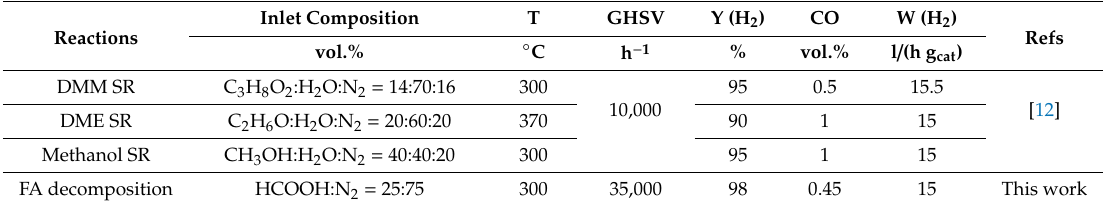
Table 3. Performance of the CuO-CeO 2 / γ -Al 2 O 3 catalyst in dimethoxymethane, dimethyl ether, methanol steam reforming and FA